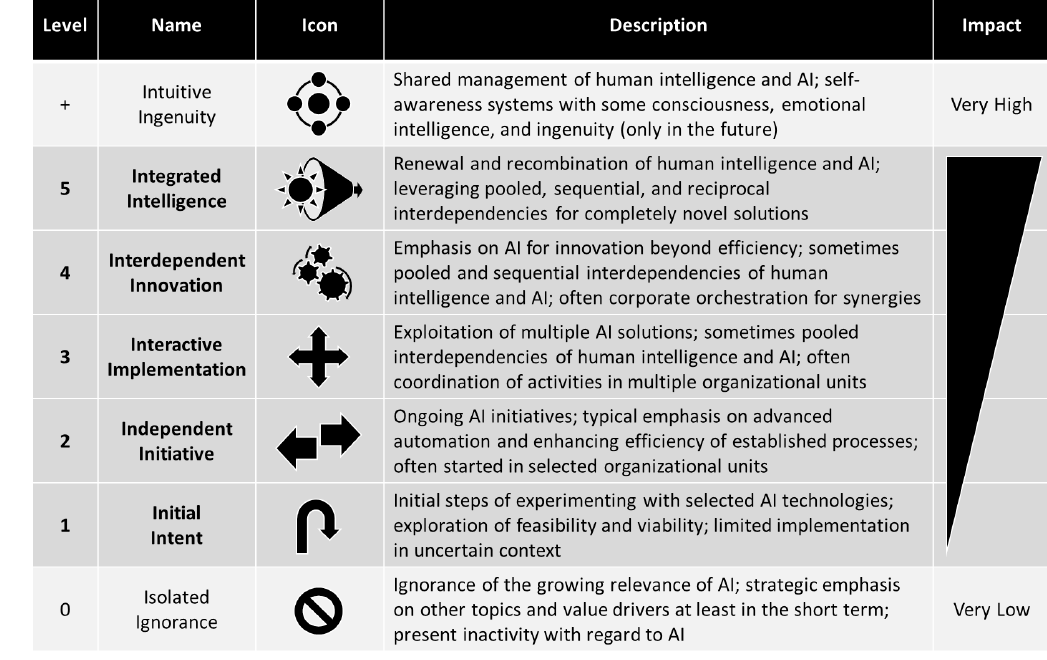
Fig. 1. AI management framework with five maturity